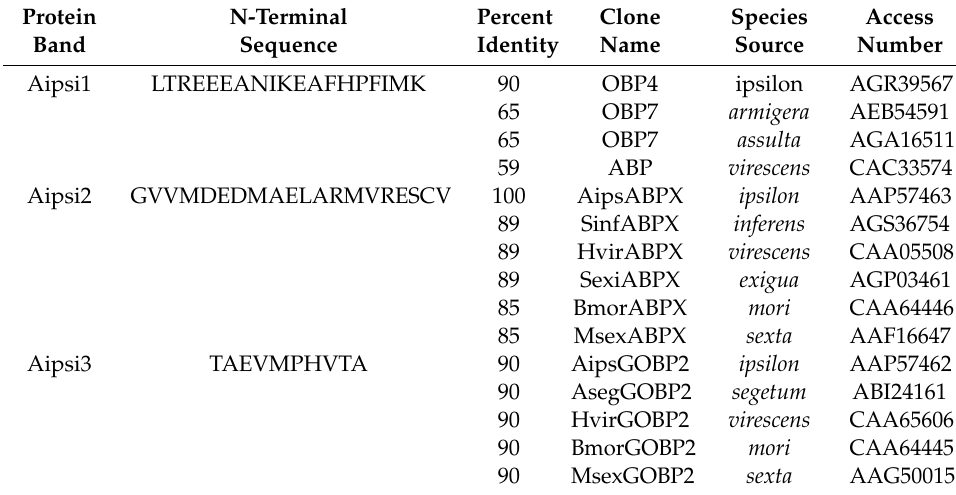
Table 1. N-terminal peptide sequence identity of moth odorant-binding proteins. Conserved amino acid motifs in the N-terminus are underlined. Genus source: Agrotis , Bombyx , Heliothis , Manduca , Sesamia and Spodoptera